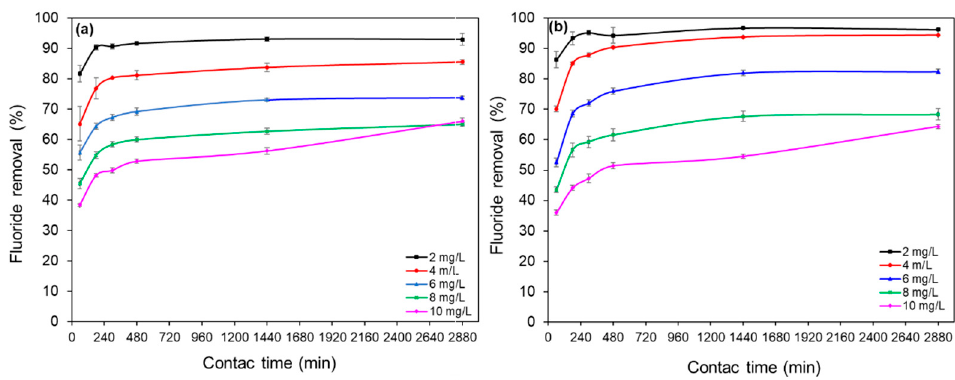
Figure 2. Fluoride removal (%) by bioadsorbents vs. contact time. ( a ) Orange peel, ( b ) apple peel.